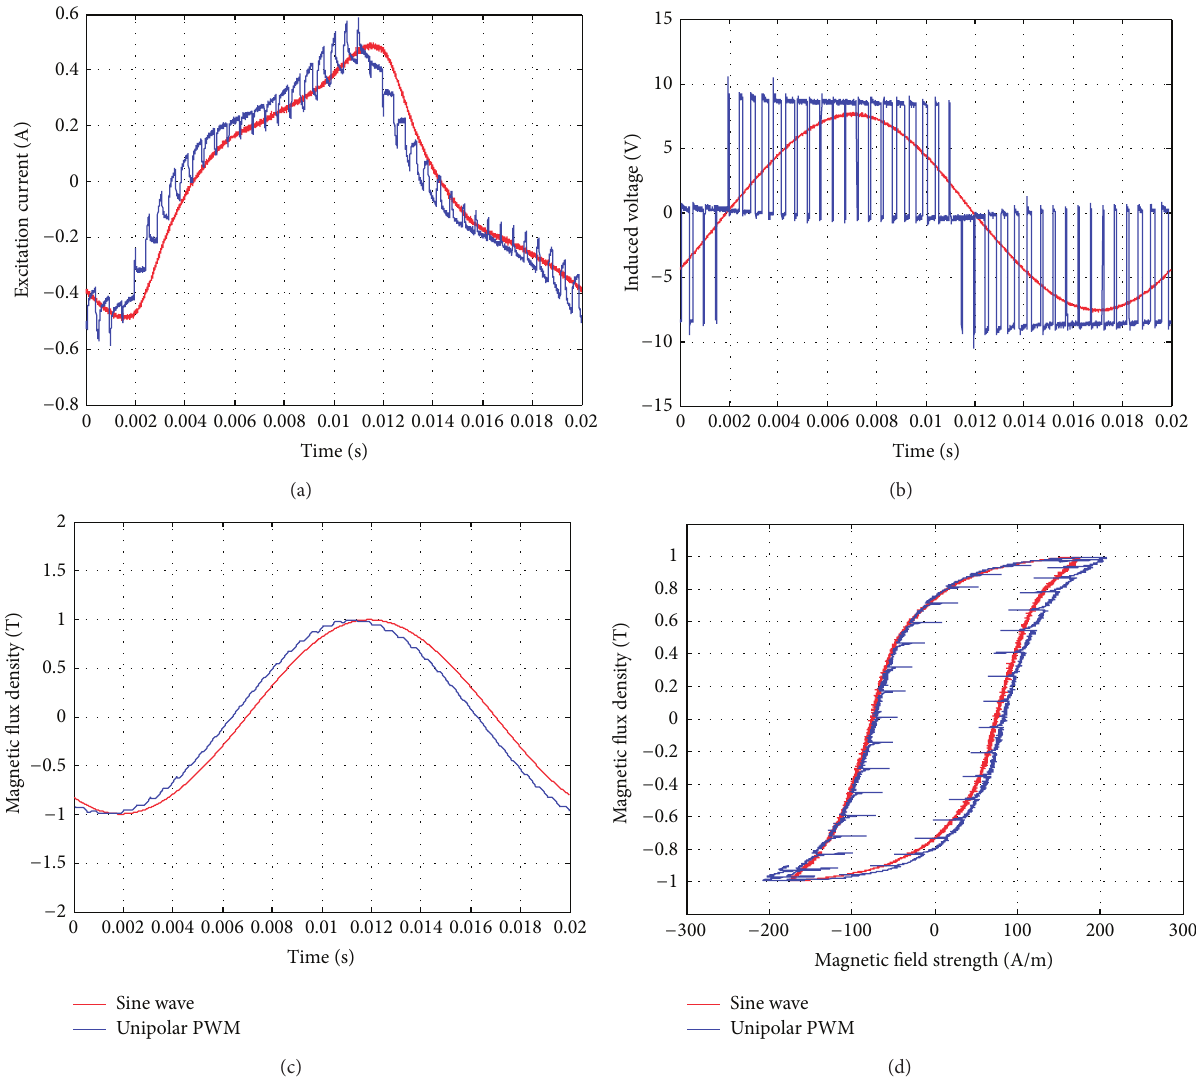
Figure 17: Parameters measured using the new toroidal frame for sinusoidal waveforms and unipolar PWM (with 𝐵 = 1 T, 𝑓 = 50 Hz, = 0.9 , and 𝑚 = 20 ): (a) excitation current, (b) induced voltage, (c) flux density, and (d) hysteresis curve. 𝑚 𝑎 𝑓